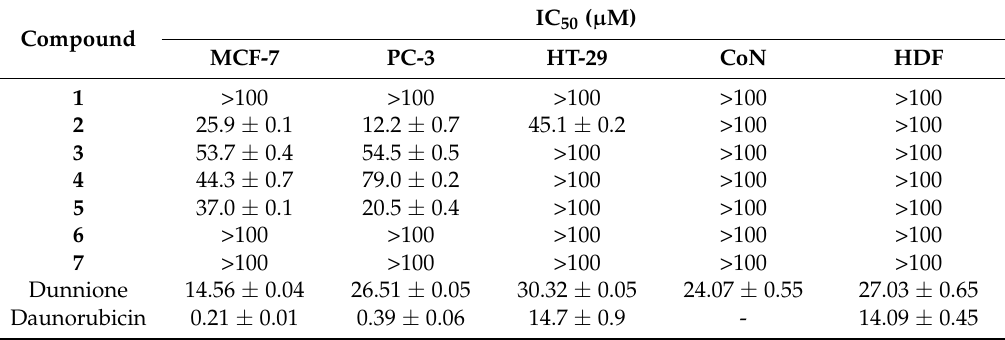
Table 1. In vitro cytotoxic activity of natural compound 1 and derivatives 2 – 7